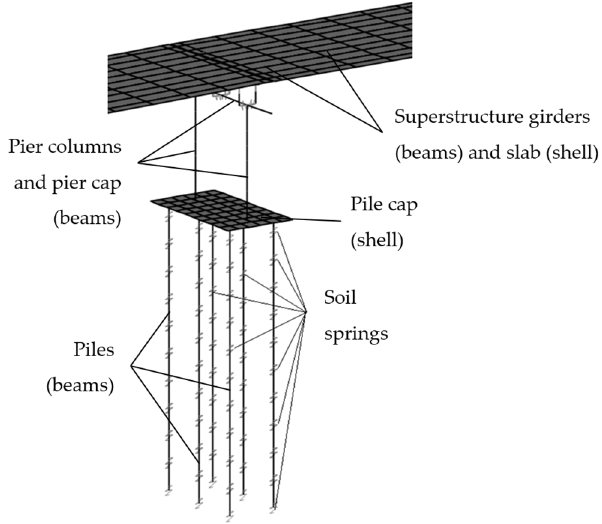
Figure 5. Typical design finite element model in CSiBridge.